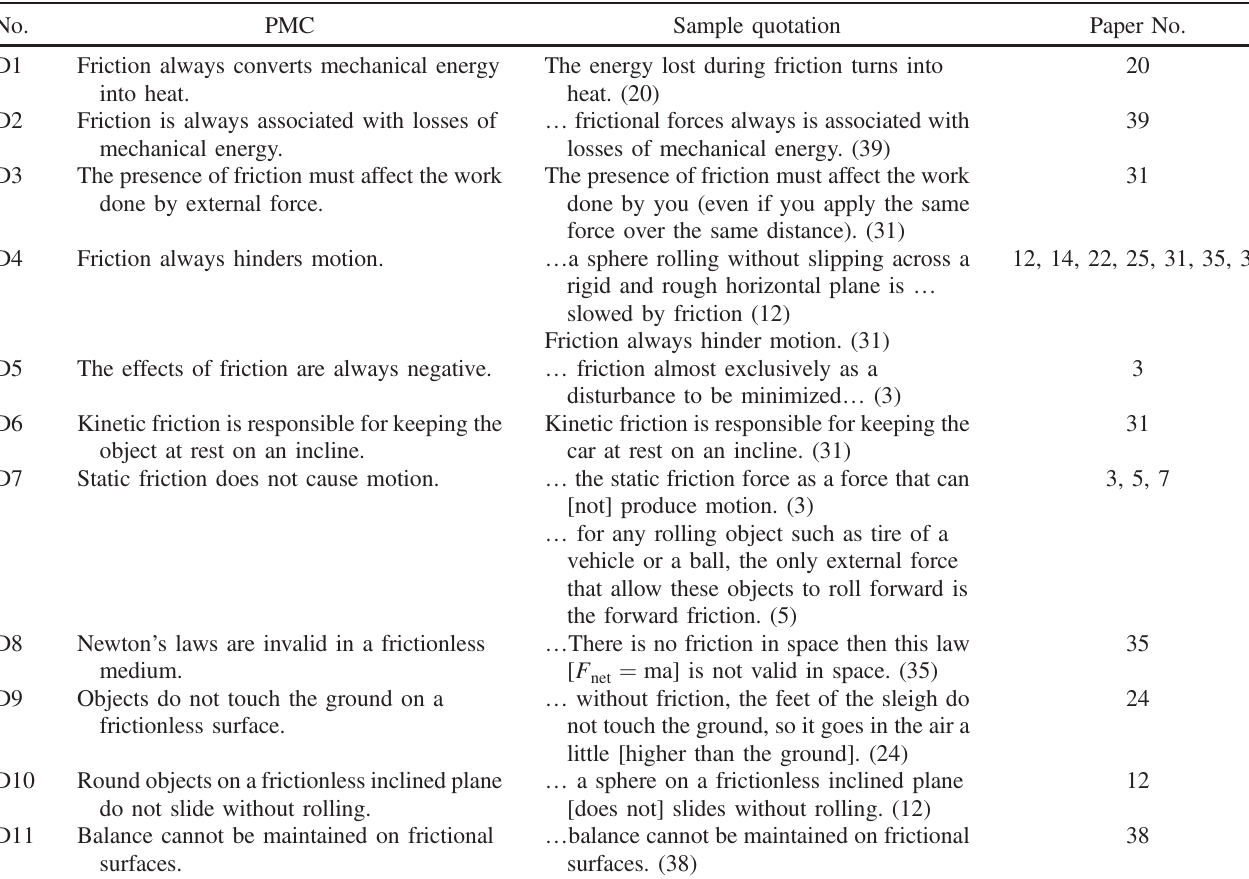
TABLE VI. PMCs related to the effects of friction. No. into heat. Friction is always associated with losses of mechanical